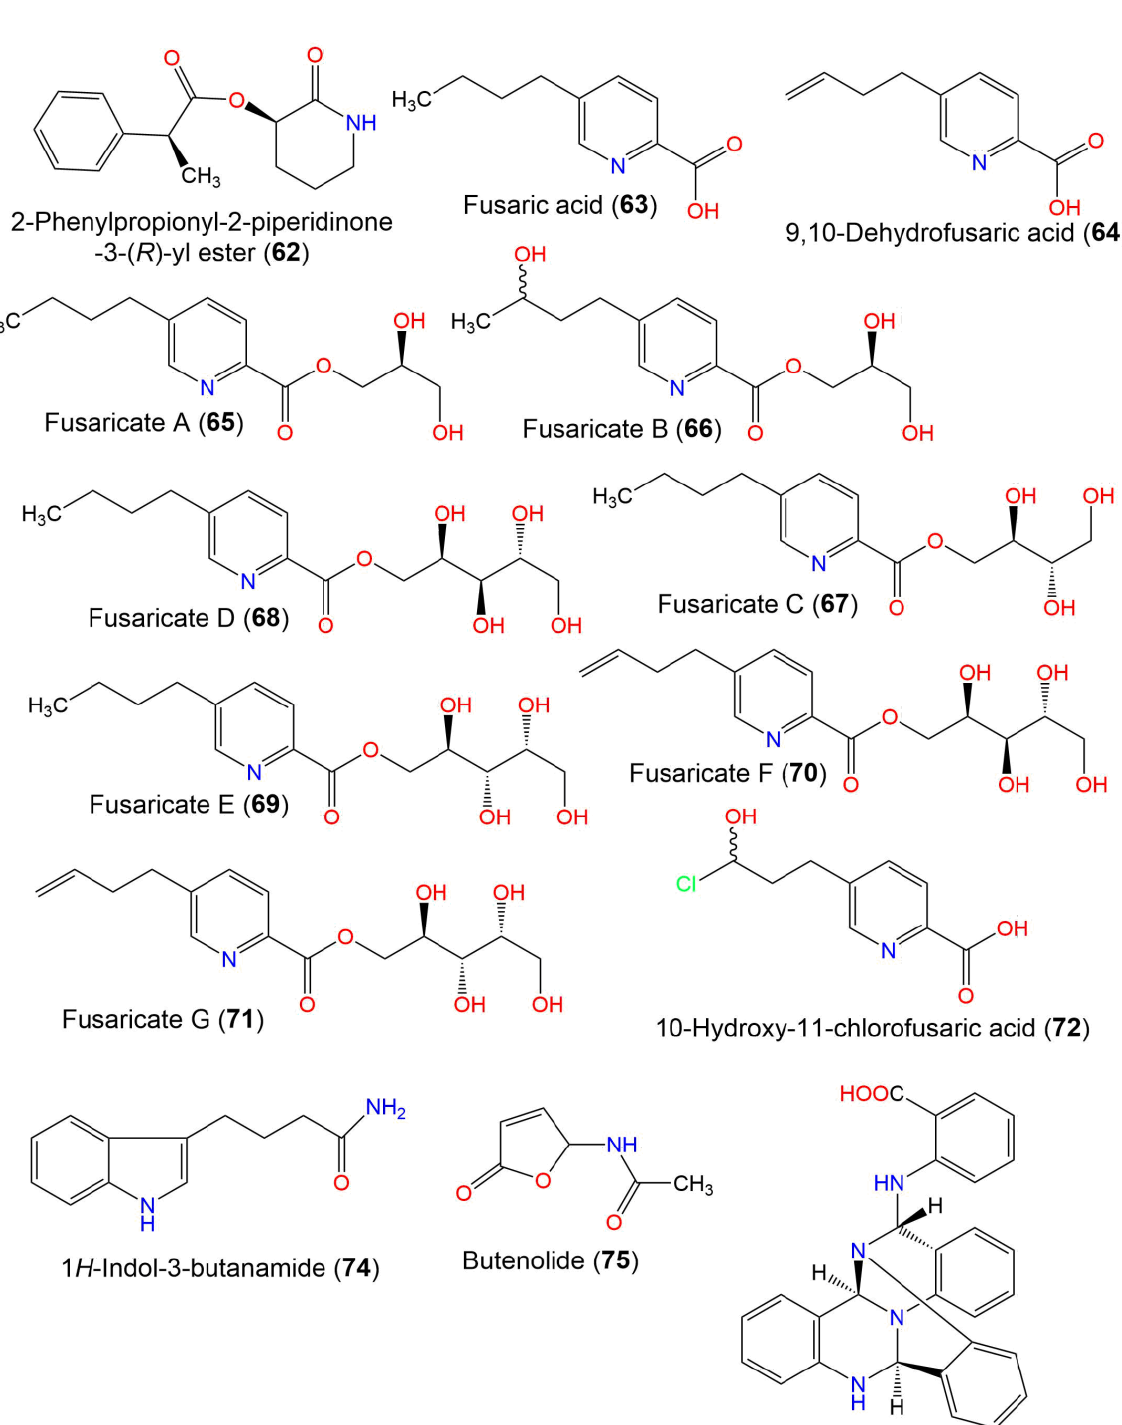
Figure 6. Structures of alkaloids ( 62 – 75 ) isolated from F. oxysporum . 2-Oxo-8-azatricyclo [9.3.1.1 3,7 ]-hexadeca-1(15),3(16),4,6,11,13-hexaen-10-one ( 80 )